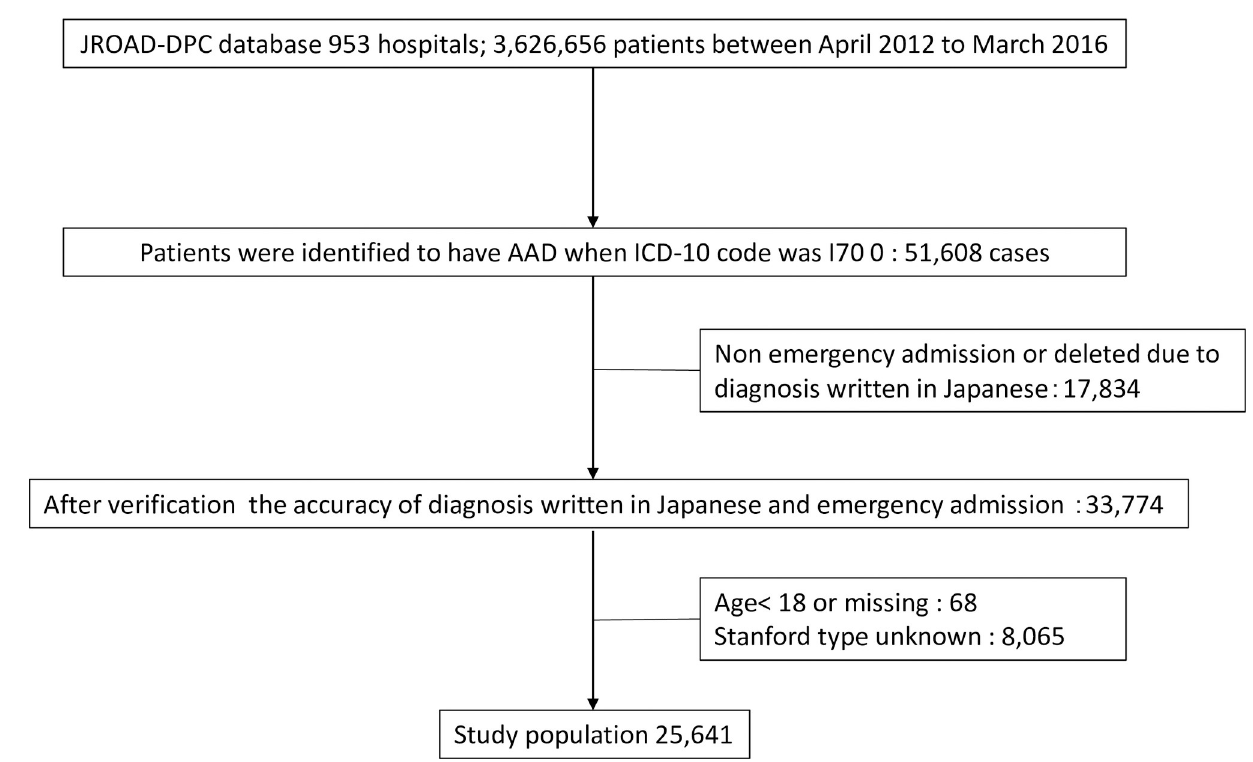
Fig 1. Flow chart of the patient selection process. JROAD-DPC, Japanese Registry of all Cardiac and Vascular Diseases Diagnostic Procedure Combination; ICD-10, 10th revision of the International Classification of Disease.